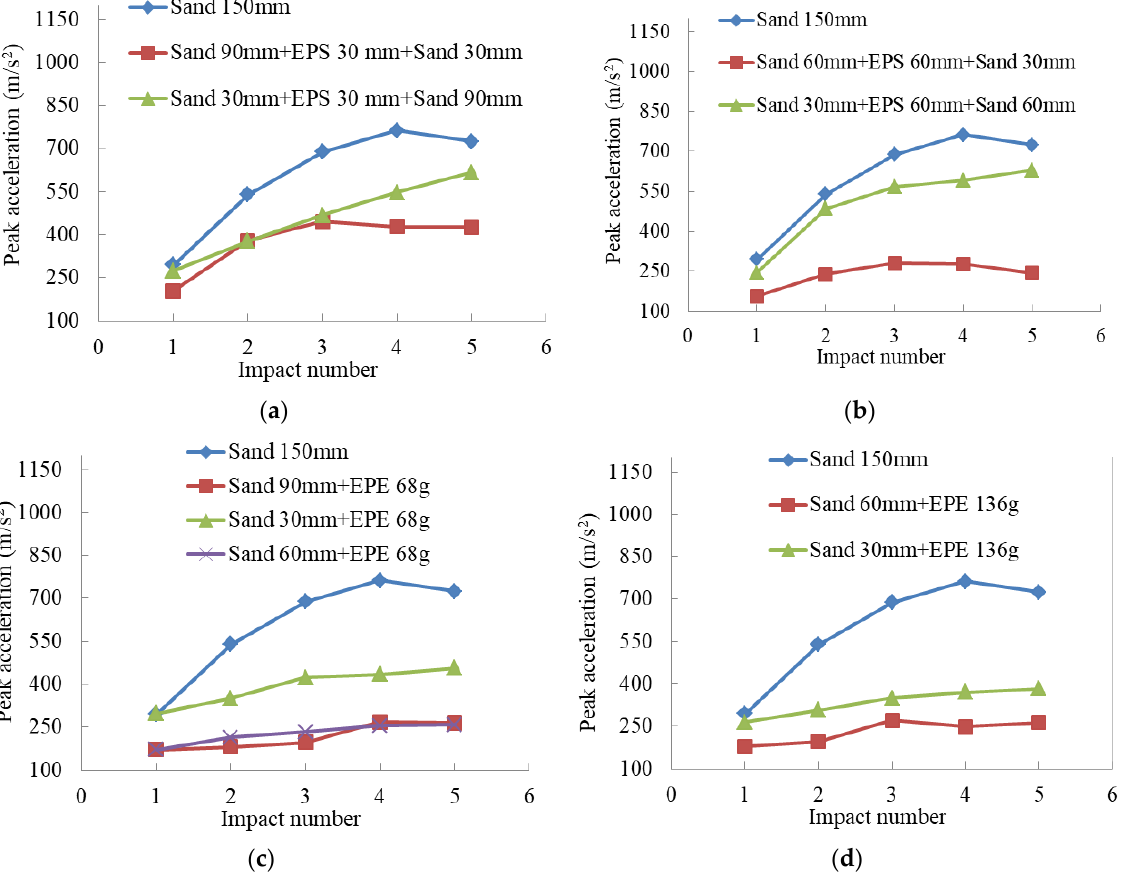
Figure 15. Variation curve of the acceleration with the impact number for different placement